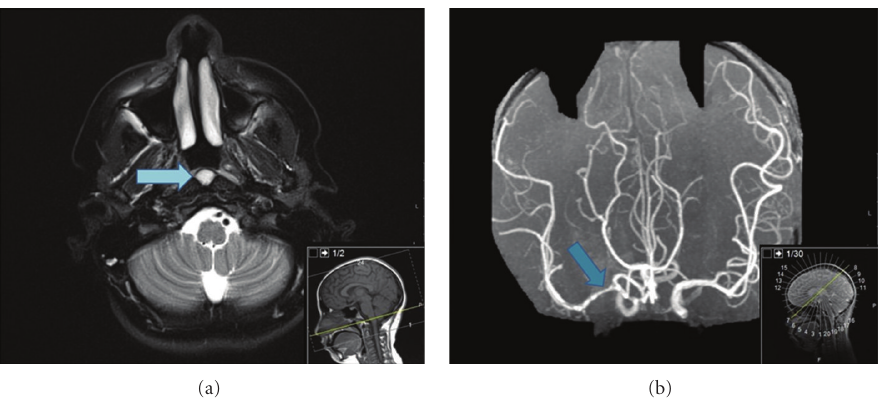
Figure 2: Magnetic resonance images from patient depicting abnormal findings. (a) Axial T2 weighted MR image through the nasopharynx demonstrating a small well-circumscribed T2 hyperintense, CSF-like cyst nestled between the longus colli muscles deep to the nasopharyngeal mucosa consistent with an uncomplicated Tornwaldt’s cyst (arrow). (b) 3D time-of-flight MRA of the intracranial circulation demonstrating narrowing and irregularities with the wall of the M1 segment of the right middle cerebral artery (arrow) indicating, but not limited to, arteritis or